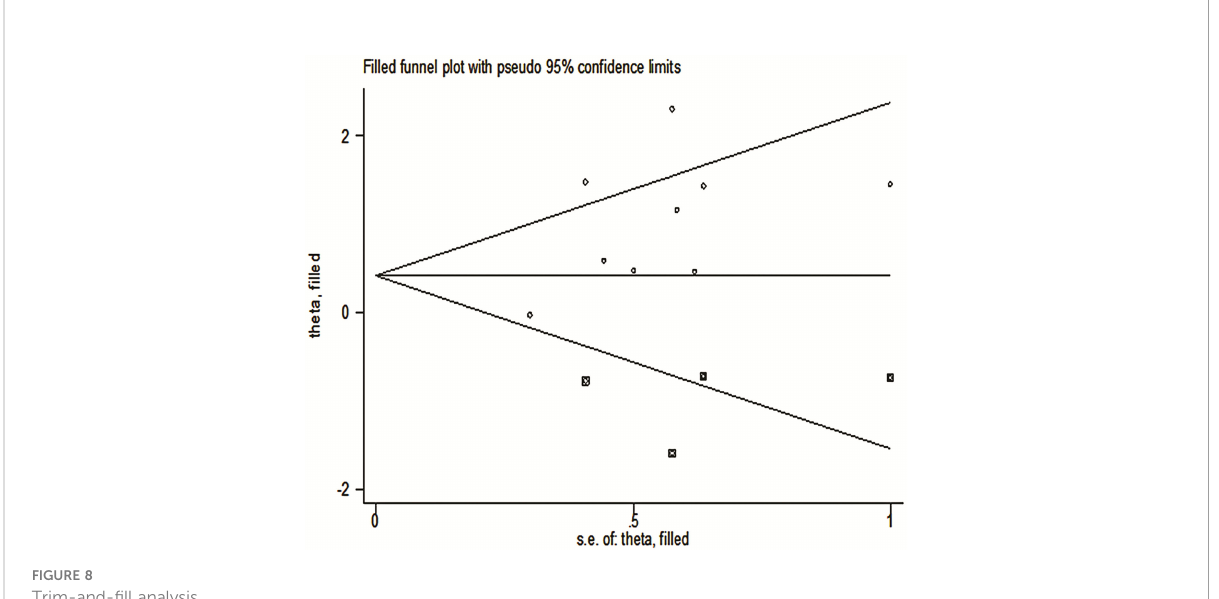
FIGURE 8 Trim-and- fi ll